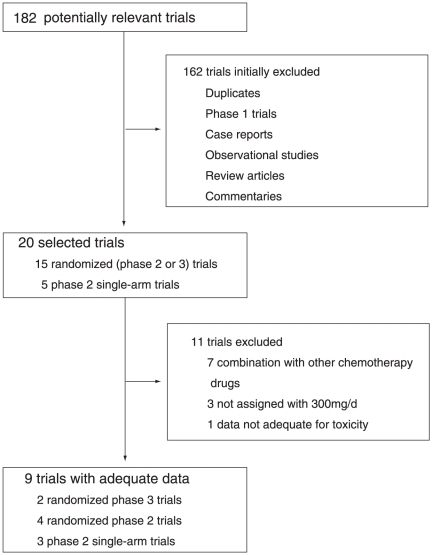
Selection process for trials.